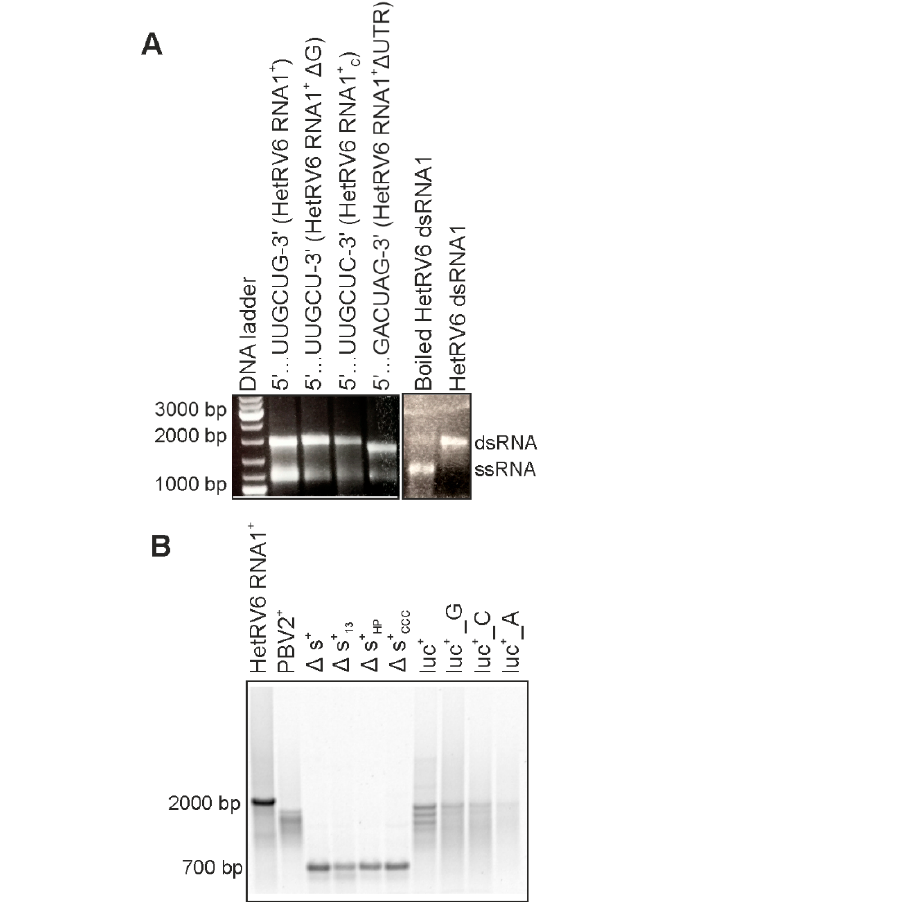
Figure 2. HetRV6 RdRp activity on native and heterologous templates. ( A ) Full-length HetRV6 RNA1 + and its modifications were used as templates in RNA polymerization reactions. The reaction products were analyzed by native agarose gel. The effect of boiling on the synthesized HetRV6 dsRNA1 reaction products is shown on the right. ( B ) Heterologous (+)RNA templates of viral and non-viral origin with variable 3 ′ -ends were used as templates (refer to Table 1 for details). Native HetRV6 RNA1 + template was included as a control. The reaction products were analyzed by electrophoresis in native agarose gel, and corresponding autoradiogram is shown.